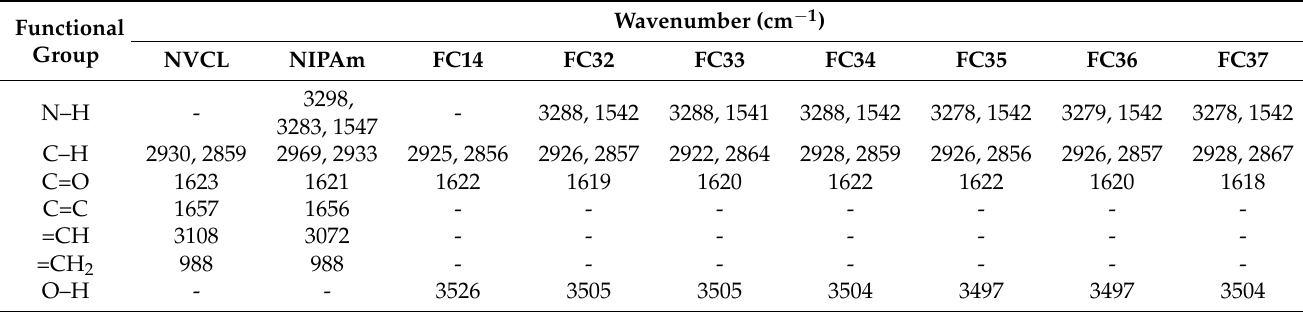
Figure 2. FTIR spectra showing peaks detected from monomers vanished in synthesised copolymers. Table 1. Some important FTIR bands for monomers and synthesised copolymers.